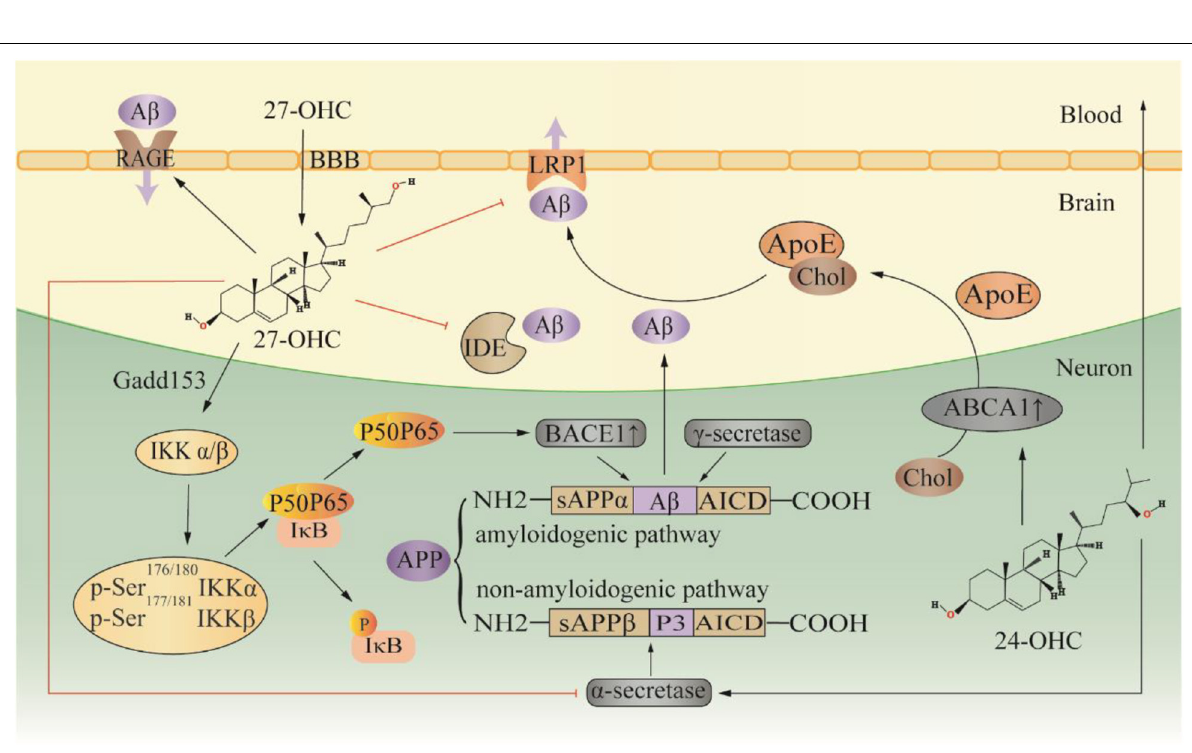
Frontiers in Neuroscience |